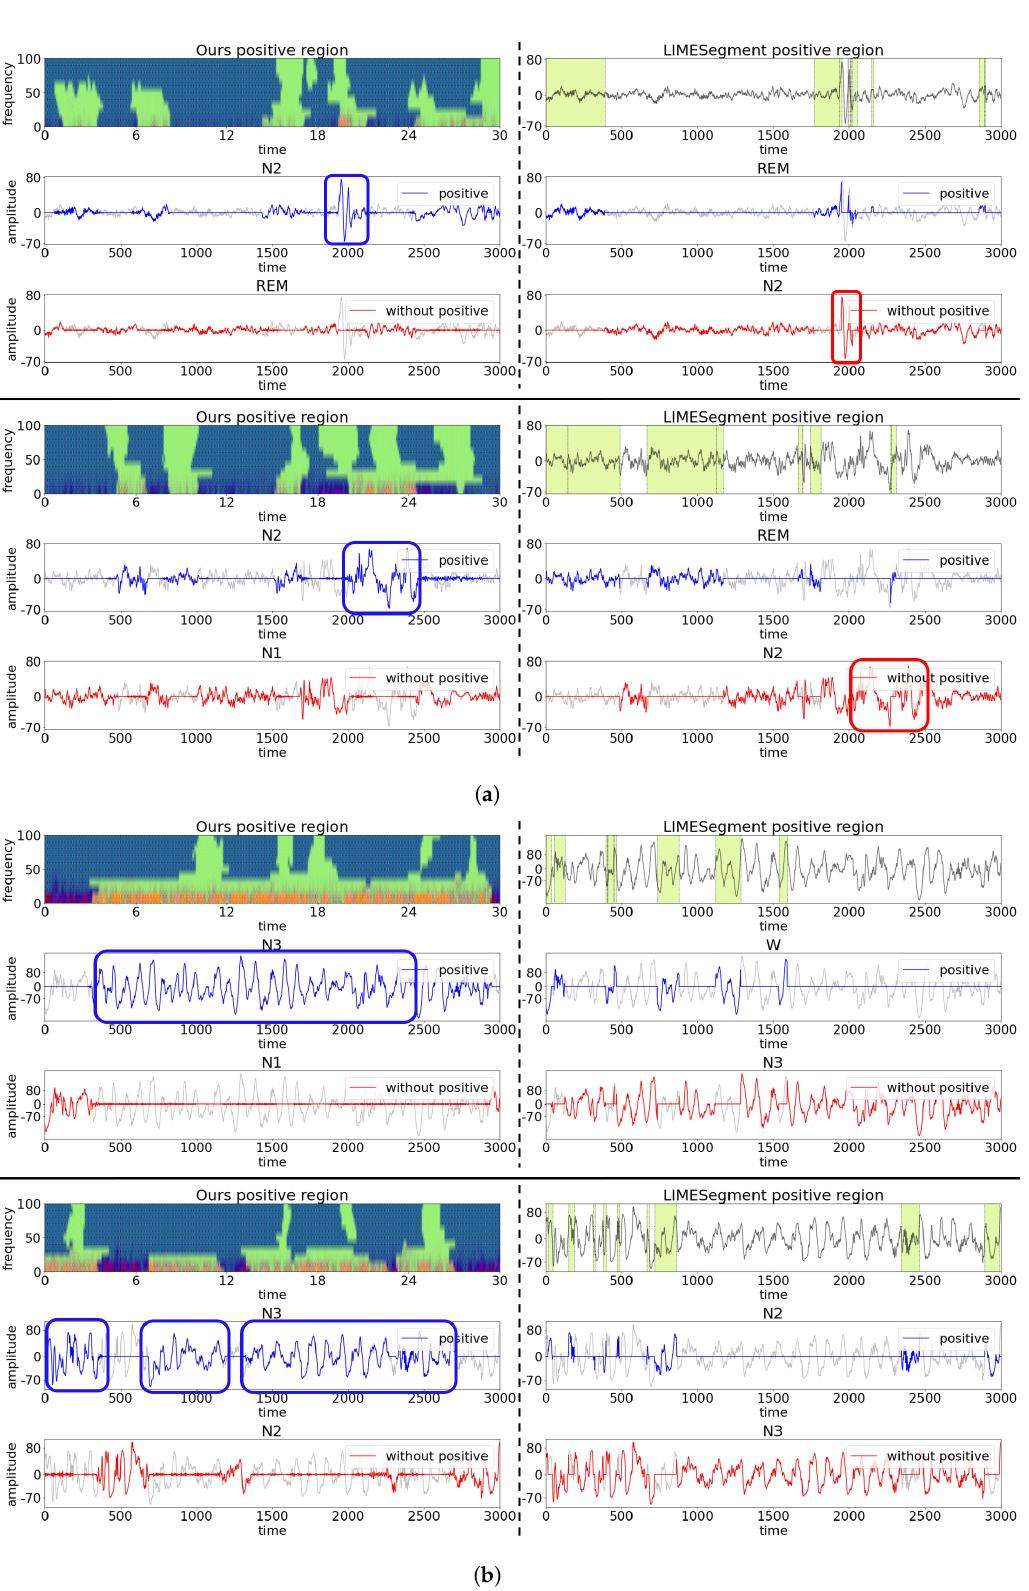
Figure 3. We depict how the representations are critical for the decision of the target model. The blue box and the red box indicate the most probable positive explanation of the target model and the most probable negative explanation of the target model given the signal respectively. They can be acquired to support physicians to interpret the target model. ( a ) Original sleep stage of the EEG samples is N2. ( b ) Original sleep stage of the EEG samples is